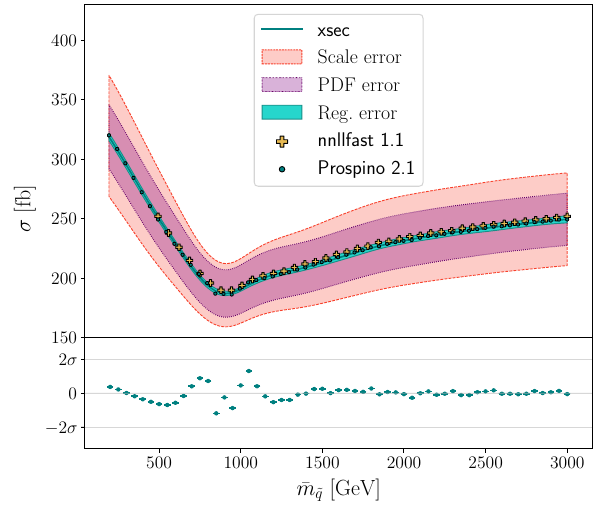
Fig. 3 Gluino pair-production cross-section as a function of average first and second-generation squark mass. The gluino mass is fixed at 1TeV. Shown are the central xsec prediction (solid line), the 1 σ regres- sion error band (light green), the scale error (pink), the PDF error (vio- let),the Prospino values(dots)andthecorresponding NNLL-fast NLO result (crosses)